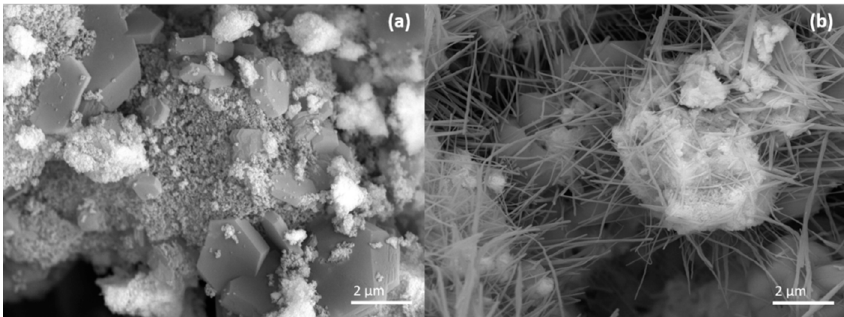
Figure 7. SEM Image at 20 Kx magnification of (a) CZA and (b) K/CZA.